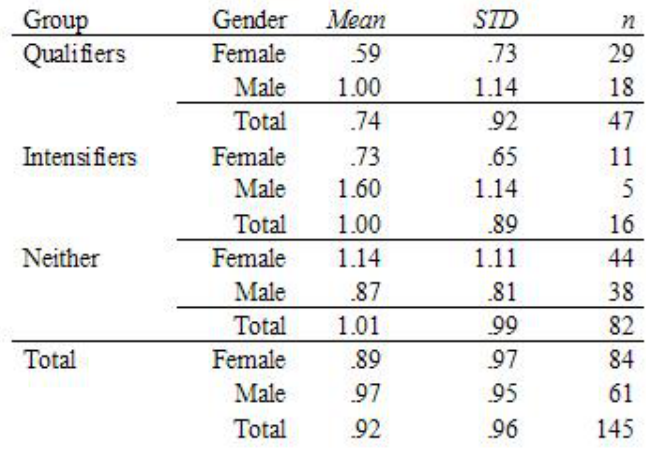
Table 4. Mean number of challenges elicited by arguments presented by group and by gender